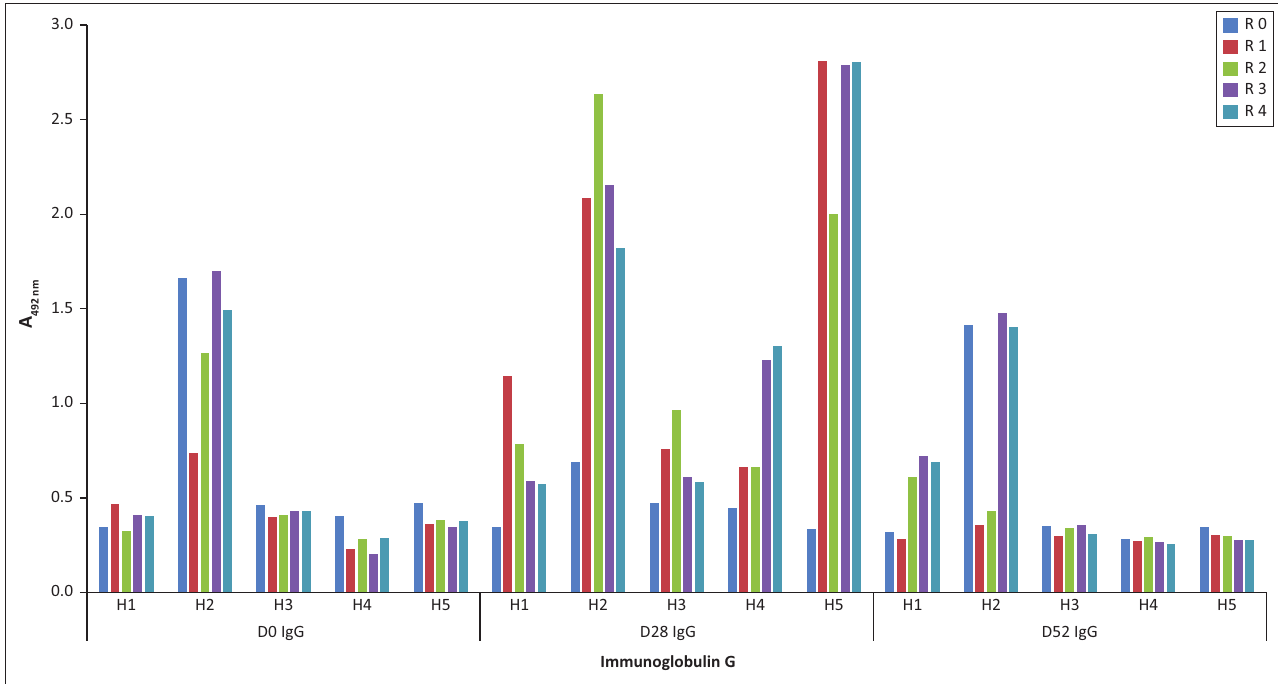
FIGURE 3: Enzyme-linked immunosorbent assay showing the pool of fusion phages in the unpanned library (R0) and phages selected during the four rounds of panning (R1 – R4) with day 0, 28 and 52 IgG of all five horses, reacting with their respective IgG. Each plotted value is an average of duplicate wells. Milk powder–negative control data have been subtracted from the experimental data.